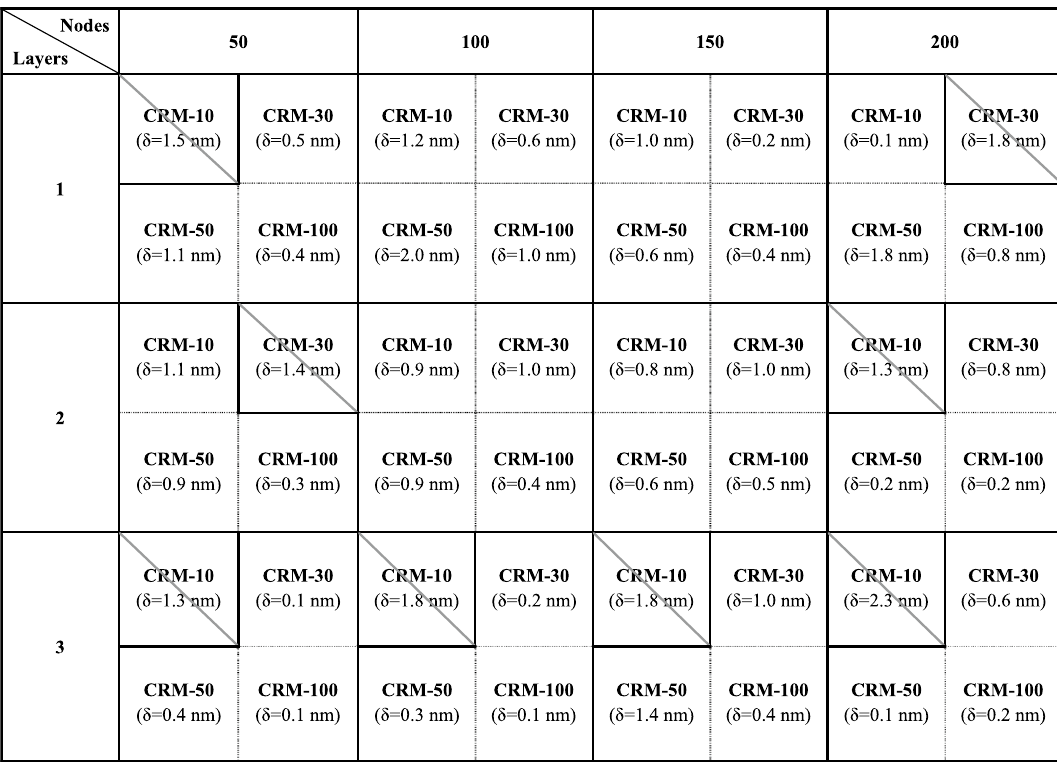
Table 2. Summary of verification of the ANN algorithms. Diagonal down bordered column represents that the analyzed value not agreed with the corresponding certified